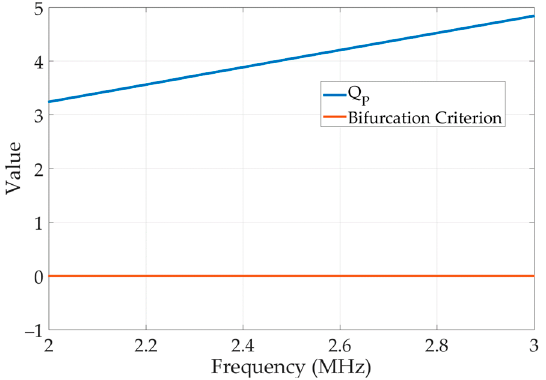
Figure 16. The comparison of the Q P and bifurcation criterion.